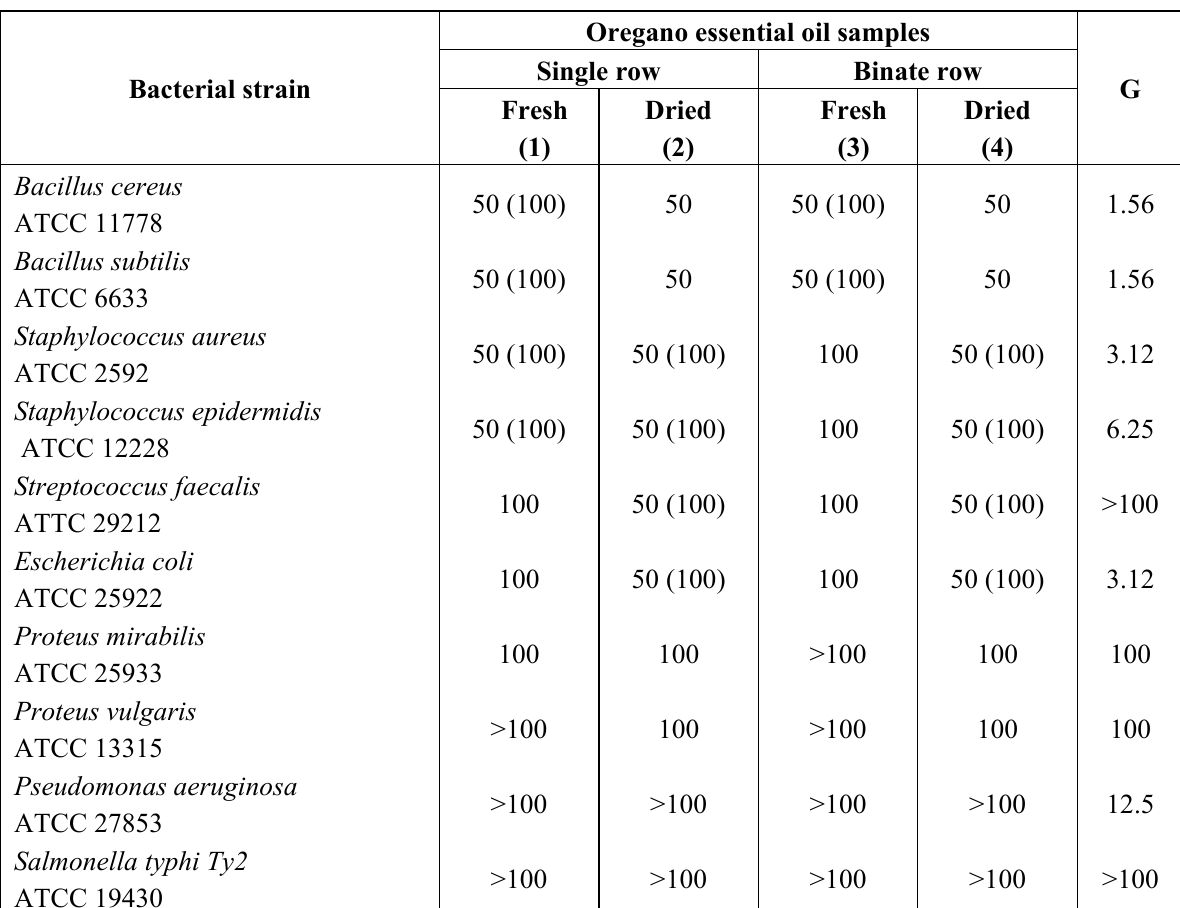
Table 3. MIC and MBC* values (µg/mL) of essential oils from Origanum vulgare L. subsp. vulgare L. at full bloom and MIC of reference